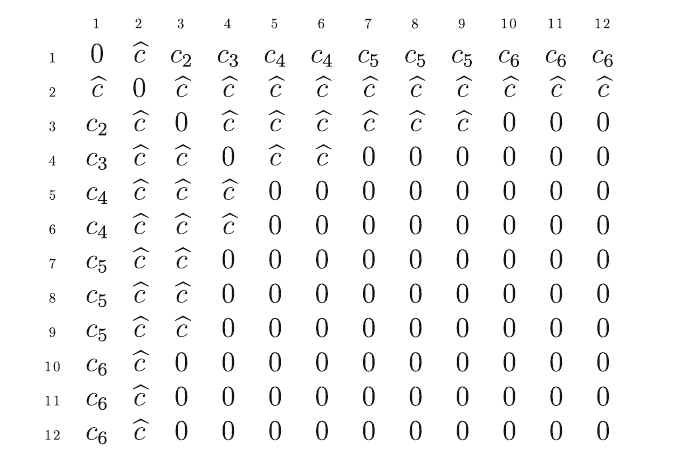
Fig. 3 Link-investment matrix of a simple DNSG